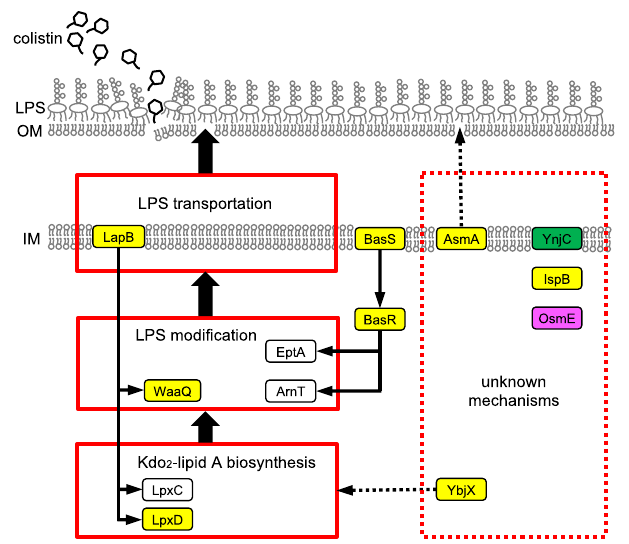
Fig. 5 Overview of genes under selection in the cultures experimentally evolved to be colistin resistant. Genes highly ranked by both EA Integral and frequency-based analysis are colored yellow; EA-speci fi c genes, green; frequency-speci fi c genes,